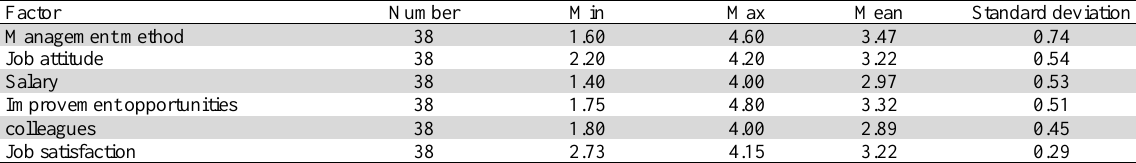
The results of some statistical